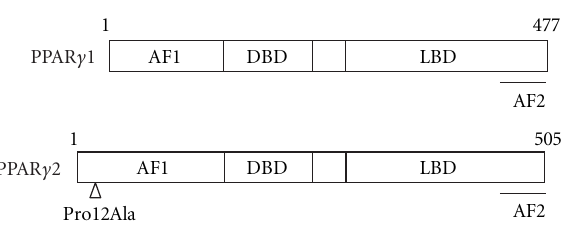
Figure 1: Domain structure of human PPAR γ . AF1, activation function 1; DBD, DNA binding domain; LBD, ligand binding domain; AF2, activation function 2.